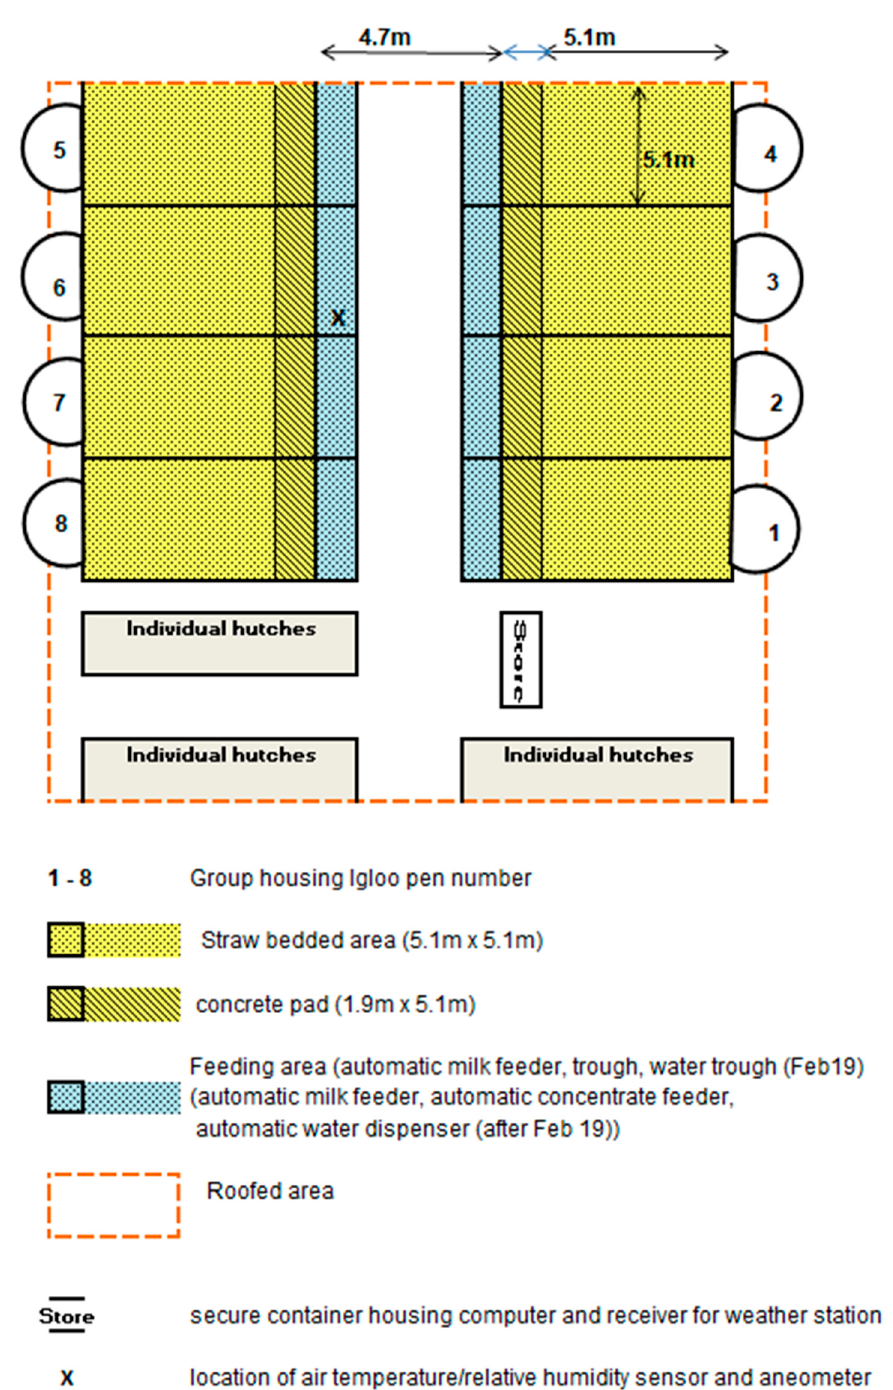
Figure 2. Illustration of the layout of the calf-rearing facility used in the study, featuring locations of individual hutches and group housing igloo pens.